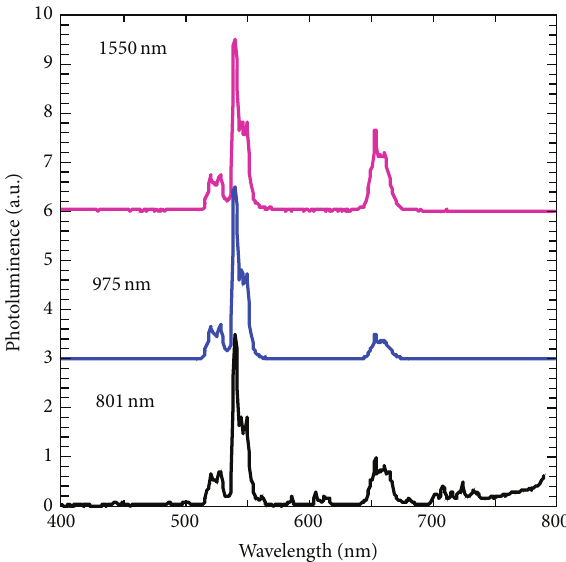
Figure 3: Upconversion spectra for Er 3+ -doped NaY 0.85 Er 0.15 F 4 , in which the Er 3+ ion acts as both sensitizer and activator. Excitation at 801nm, 975 nm, and 1550nm (black, blue and magenta curves, resp.) results in nearly identical emission spectra with a slight enhancement of the 655 nm emission for excitation at 1550